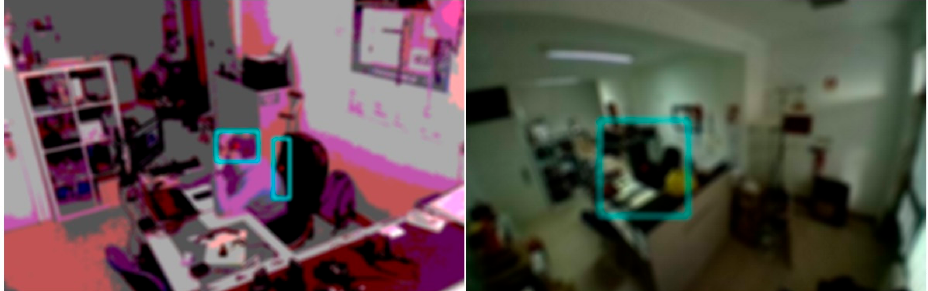
Figure 20. Angle viewing of lens: 72° ( Left ) vs. 160° ( Right